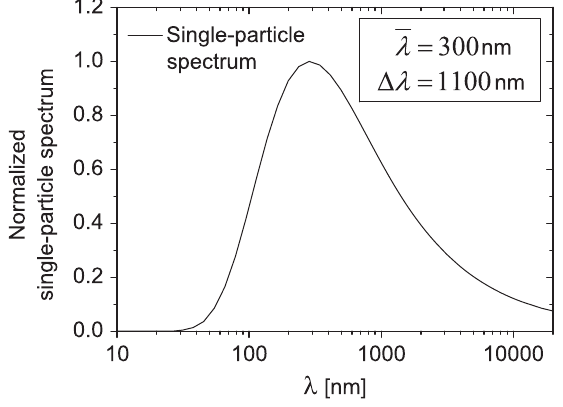
FIG. 10. Computed single-electron spectrum for the ALBA case (radius of curvature ρ ¼ 7 . 05 m and Lorentz factor γ ¼ 6000 ) at the vertical angle ψ to the average vertical position of the in-vacuum extraction mirror. The inverse bandwidth 1 = Δ ν 0 . 33 fs is much shorter than the bunch duration τ This ensures the validity of the Wiener-Khinchine theorem and temporal coherence properties are thus determined by the incident SR